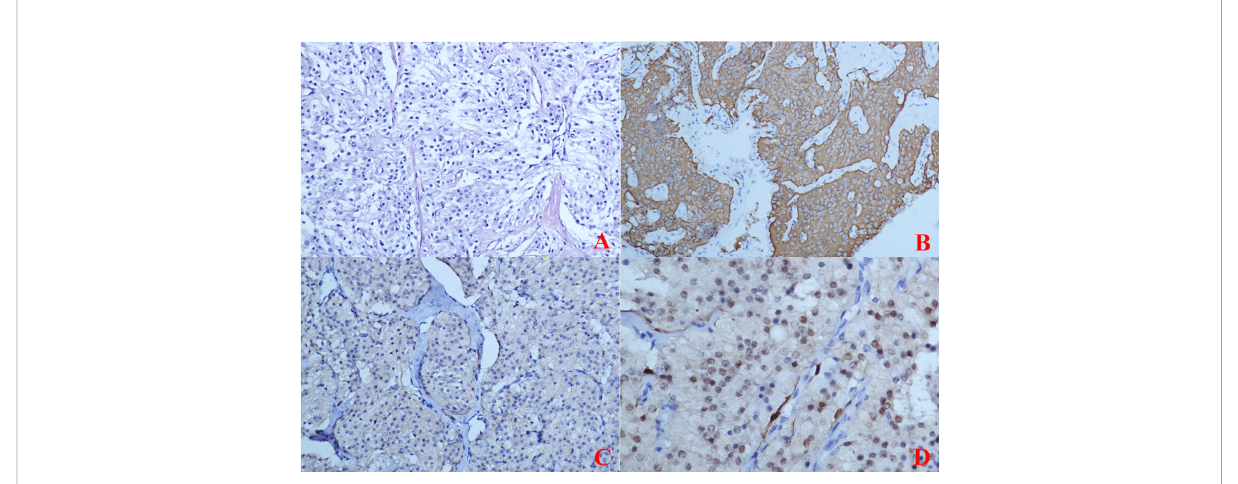
FIGURE 5 (Primary Treatment) Immunohistochemical staining: (A) The tumour cells were composed of chief cells and sustentacular cells, and they were clustered in small nests, here called zellballen, demarcated by delicate fi brous stroma and capillaries. (B) Immunohistochemical staining CgA(+); (C) Immunohistochemical staining SYN(+); (D) Immunohistochemical staining